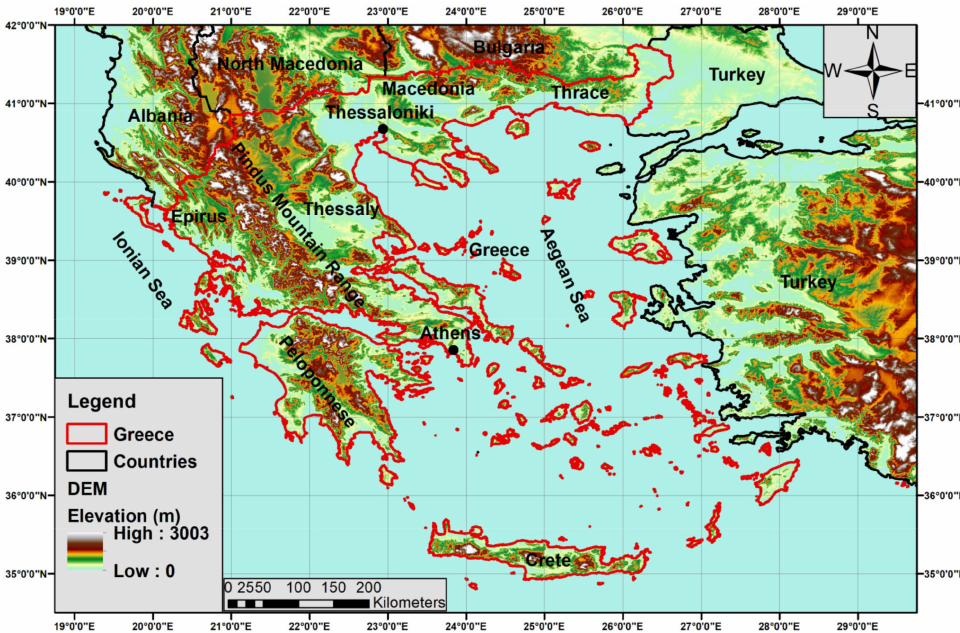
Figure 1. Study area covering the entire territory of Greece and neighboring areas. The map also demonstrates topography (m) based on Terra Advanced Spaceborne Thermal Emission and Reflection Radiometer (ASTER) Global Digital Elevation Model (GDEM) Version 3 (ASTGTM) data at a spatial resolution of approximately 30 m [38].